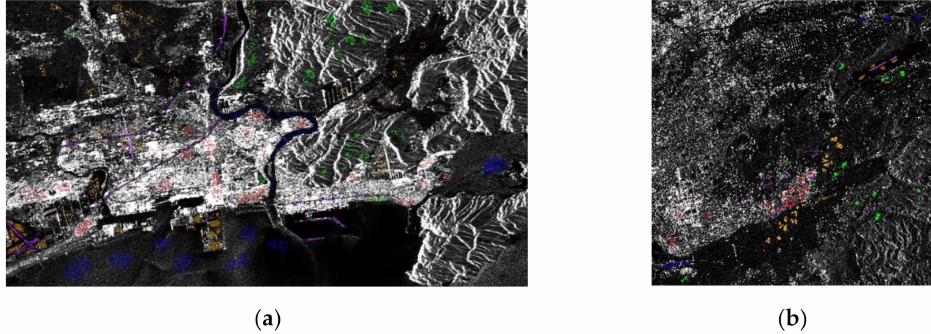
Figure 10. Built-up area samples (red) and non-building area samples (water samples—blue, road samples—purple, bare soil samples—brown, mountain vegetation samples—green, farmland samples—orange) in different study sites: ( a ) Ishinomaki study site; ( b ) Mashiki town study